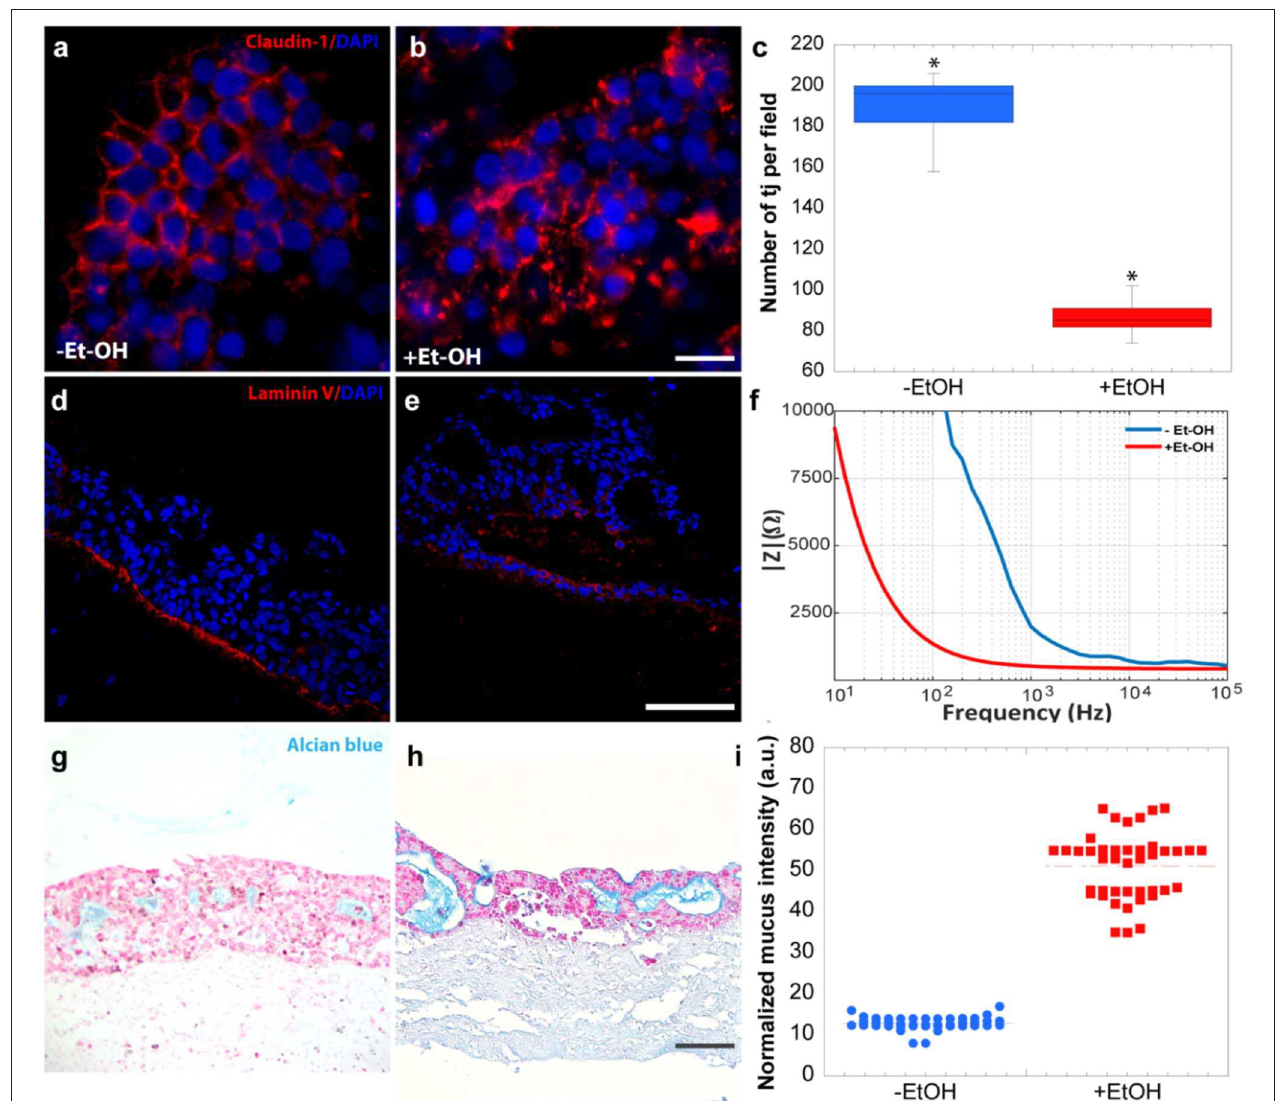
FIGURE 5 | Et-OH-induced 3D-HIM hyper-permeability at epithelial level. Comparison of the expression of the intestinal epithelial tight junction cell marker (Claudin-1) on untreated (–EtOH) 3D-HIMs (a) and 400mM Et-OH-treated ( + Et-OH) 3D-HIMs (b) ; scale bar 50 µ m. Quantitative analysis of tight junction per field (* p < 0.05) (c) ; confocal microscope analysis of immunofluorescence staining shows the Laminin V signal on untreated (–EtOH) 3D-HIMs (d) and 400mM Et-OH treated ( + Et-OH) 3D-HIMs (e) ; cell nuclei stained with DAPI scale bar 75 µ m; Quantitative analysis of TEER values (f) ; Alcian blue-stained cross-sections reveals the mucus deposition in untreated (–EtOH) 3D-HIMs (g) and 400mM Et-OH-treated ( + Et-OH) 3D-HIMs (h) ; scale bar 100 µ m; Quantitative analysis of Alcian blue-stained samples reveals the mucus production (i) . All the experiments were performed in triplicate ( n = 3); values represent the mean and the standard